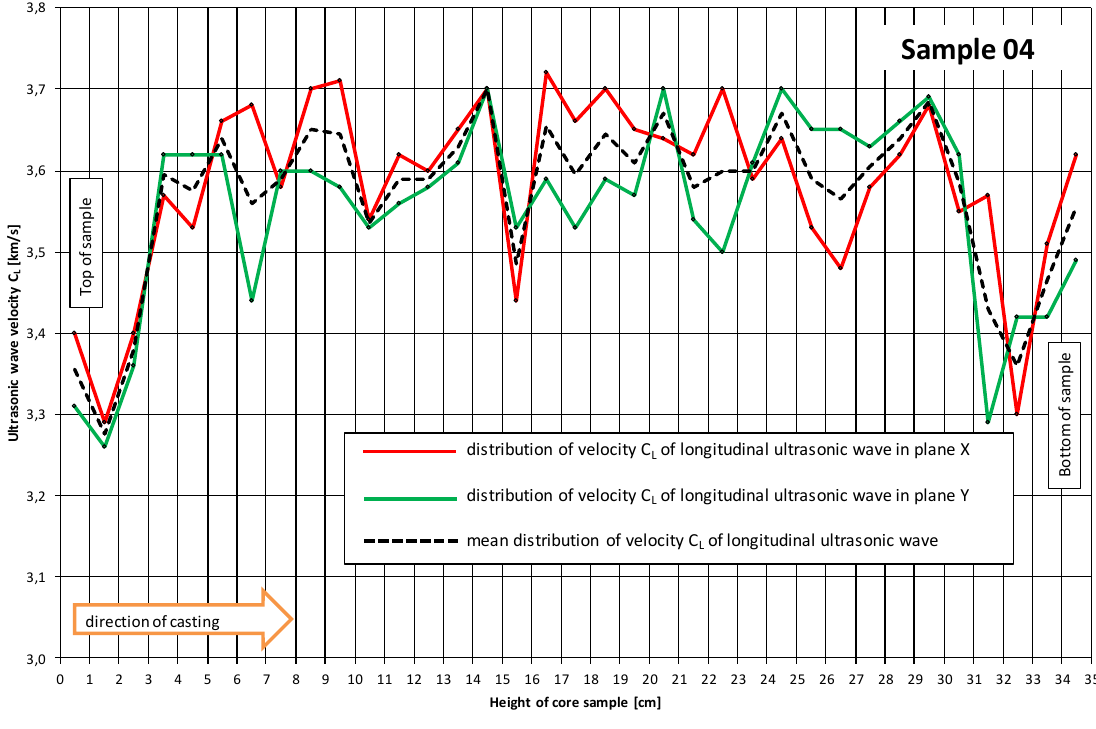
Figure 3. Exemplary distribution of velocity C L of longitudinal ultrasonic wave along the height of sample 04 taken perpendicularly to the top surface of the slab. Table 3. Velocities C L of longitudinal ultrasonic wave propagation, measured in two perpendicular directions in core samples taken parallel with the top surface of the slab. Measuring place